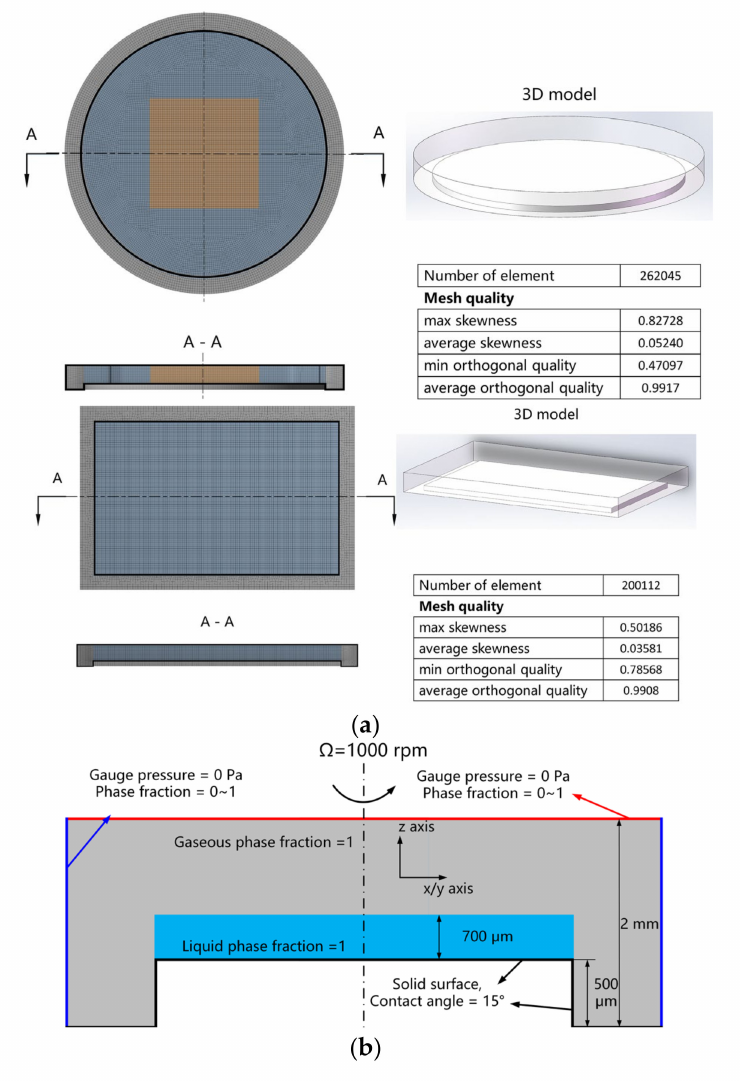
Figure 1. Numerical simulation detail of spin-coating process. ( a ) Geometric model and meshing; ( b ) Boundary conditions and characteristic